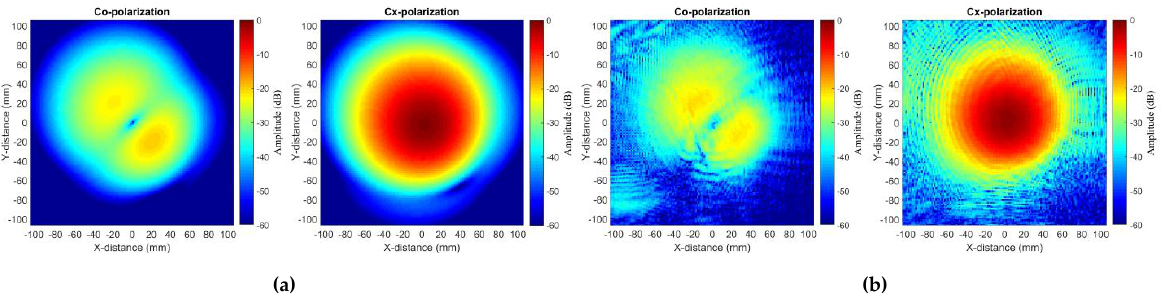
Figure 9. The far field amplitude patterns of the fabricated quasi-optical system with 𝜃 r = 𝜋/2 : (a) E-plane; (b) H-plane.